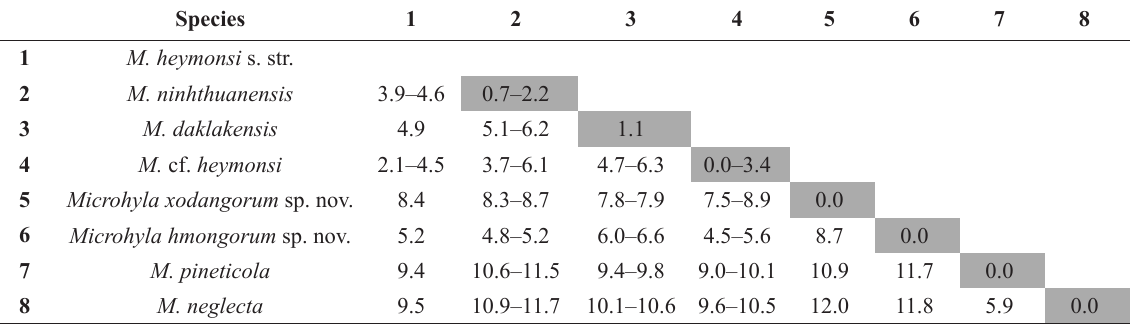
Table 2. Uncorrected (‘p’) distance matrix showing the percentage pair wise genetic divergence 12S rRNA–16S rRNA mtDNA sequences between members of the Microhyla heymonsi